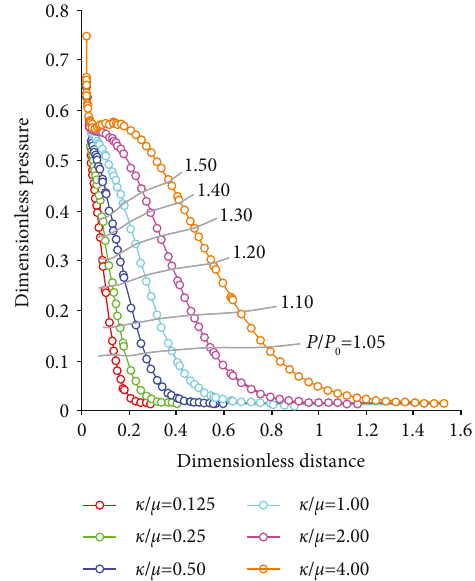
Figure 9: The change of the dimensionless pressure with the dimensionless distance along data output line 3 for di ff erent types of fl uid mobility. The value of the fl uid mobility ( k / μ ) here is calculated with the unit mD/mPa · s. The circle points are from numerical modellings. The gray curves are pore pressure disturbance contours with the initial reservoir pressure P = 30 0